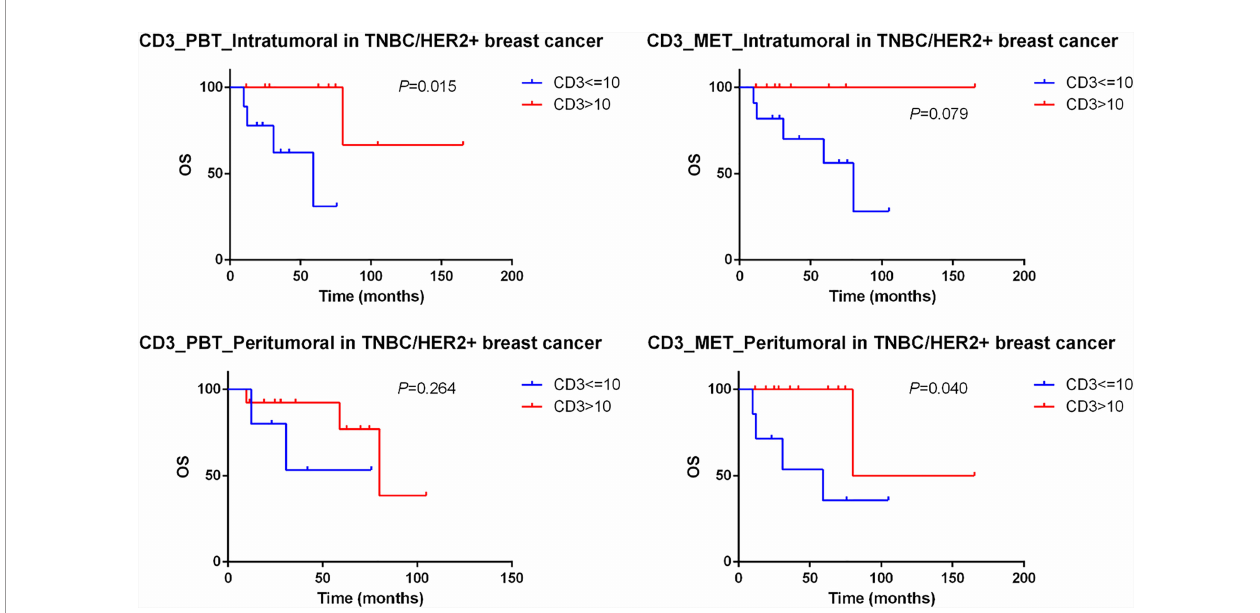
FIGURE 6 | Kaplan – Meier curve for OS of TNBC and HER2+ oligometastatic breast cancer patients strati fi ed by the expression of CD3. PBT, primary breast tissue; MET, oligometastatic